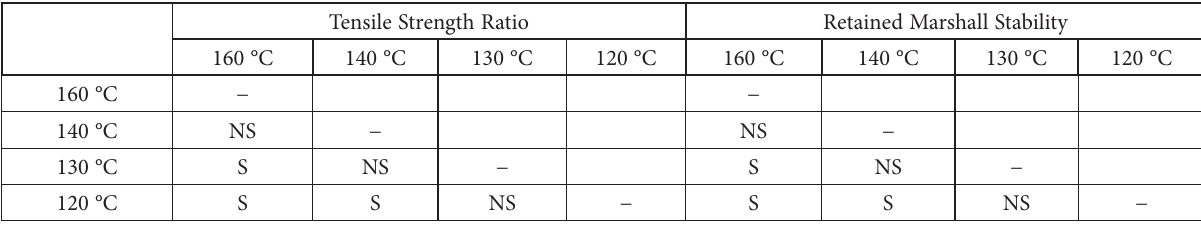
Figure 15. Retained Marshall Stability of WMA mixes Table 9. Statistical analysis results of Tensile Strength Ratio and retained Marshall stability (irrespective of additive content)